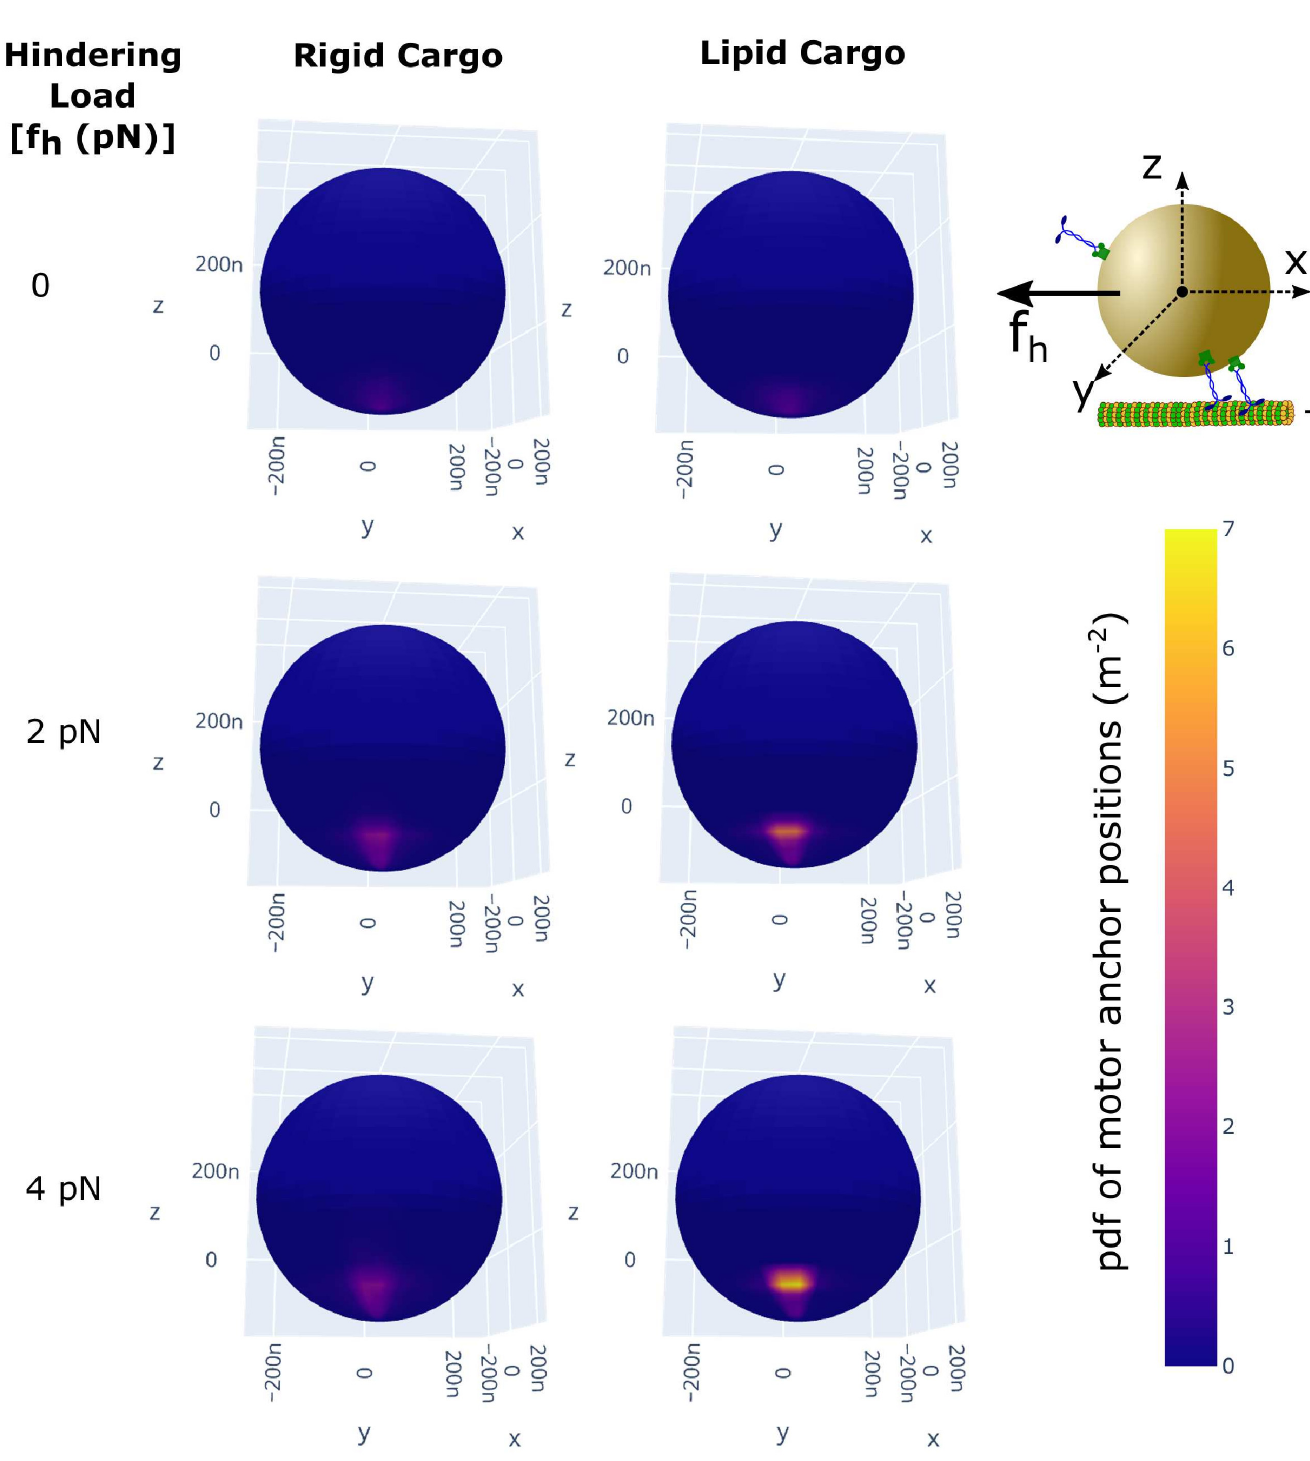
Fig 6. Motors dynamically cluster at specific locations on the lipid cargoes. Average distribution of bound motors on the cargo surface at different hindering loads ). Only multiple bound motor cases were considered. Data is from 200 cargo runs with N = 16, high [ATP] = 2 mM with anchor positions of bound on the cargo ( f h motors recorded at a sampling rate of 100 s − 1 . Anchor positions are measured relative to the body coordinate axis of the cargo (schematic at top-right). Diffusion constant of motors on lipid cargoes was 1 μm 2 s − 1